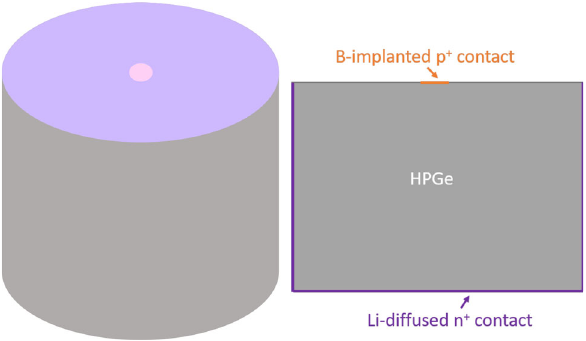
Fig. 1 Cylindrical PPC Ge detector. Left: sketch of the full detector [20]; Right: cross section. The p + contact is shown in orange and the n + contact is shown in purple